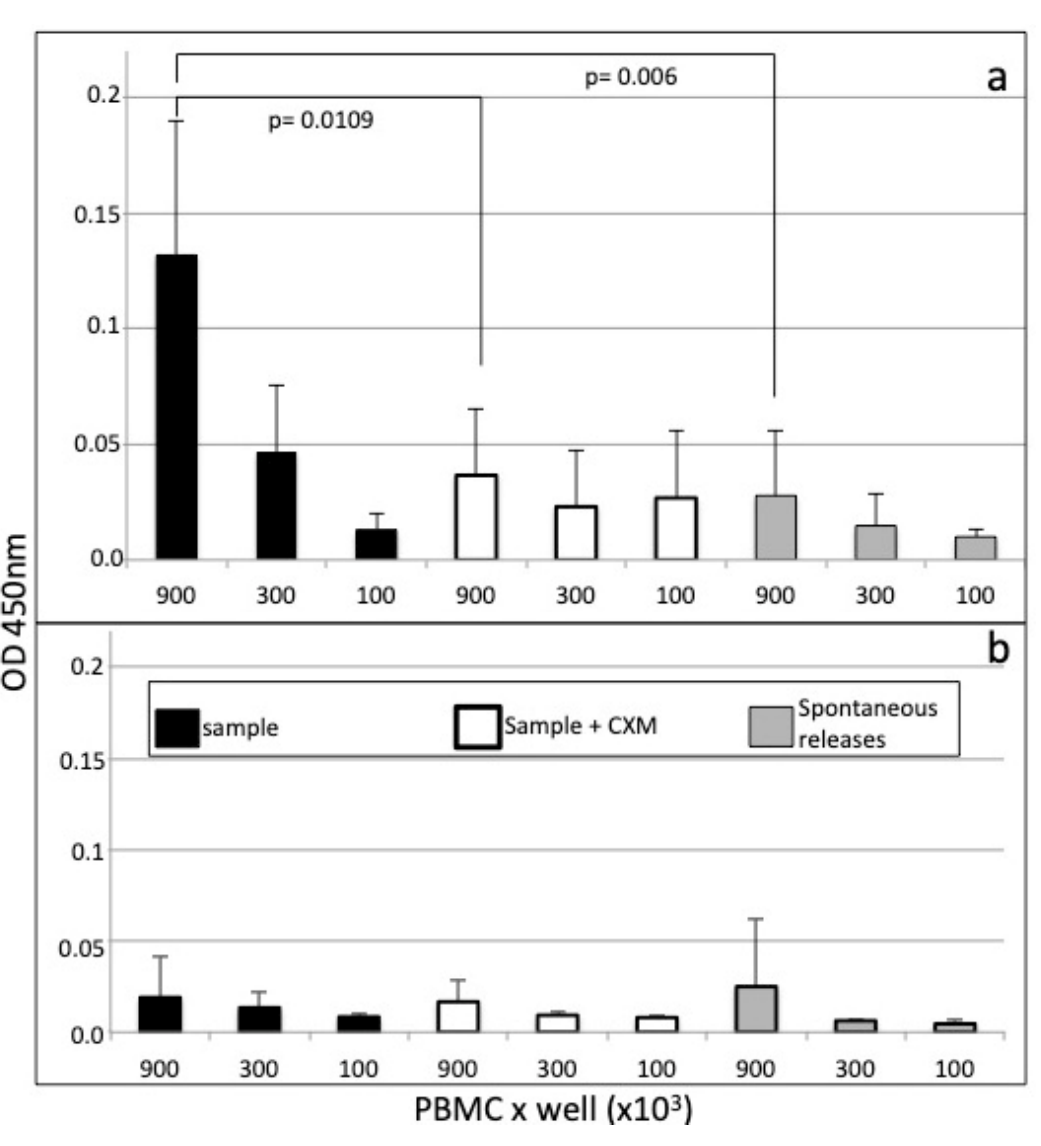
Figure 2. Cell-ELISA of in vitro-secreted IgG in PBMCs from 10 donors. The figure shows bars representing the mean ± SD net OD450 values of 5 positive ( a ) and 5 negative samples ( b ), obtained from indicated number of cells/well, incubated for 48 h in wells coated with spike S1 recombinant antigen (black bars, empty bars), or without antigen (grey bars). As control, the PBMCs were